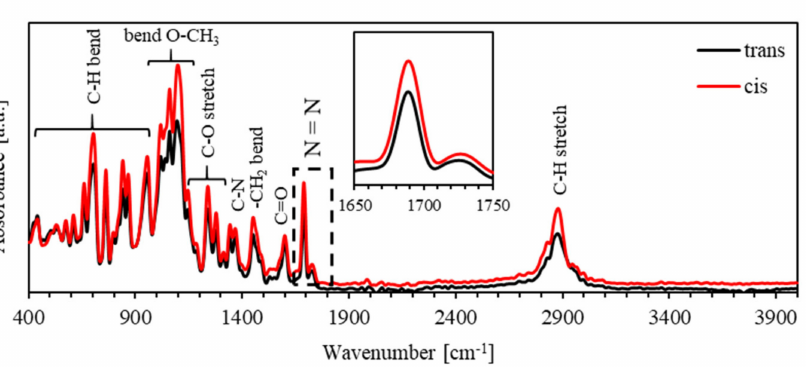
Figure 5. The FTIR spectra of trans- and cis -phases of PEO-BDK-MR polymer composite thin